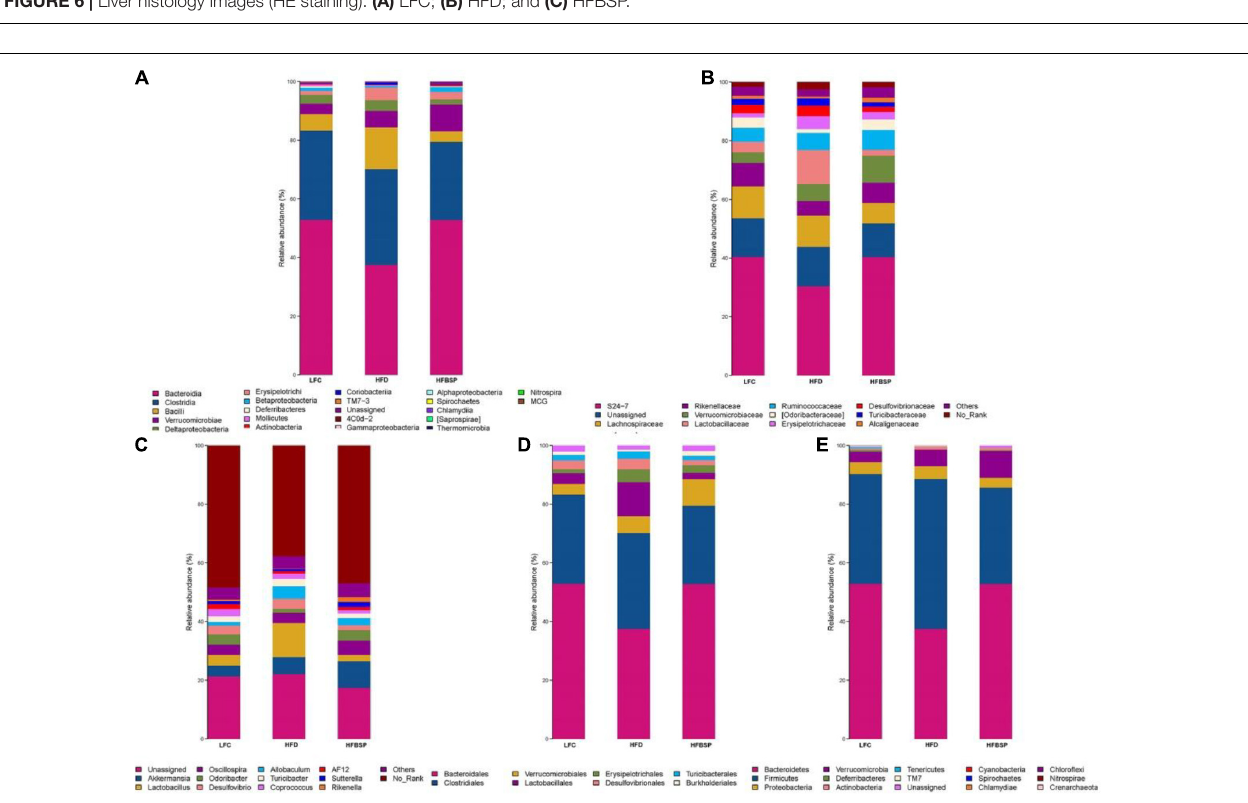
FIGURE 7 | Characterization of the natural gut microbiota of across LFC, HFD, and HFBSP mice ( n = 10/group) at the class (A) , family (B) , genus (C) , order (D) , and phylum (E)